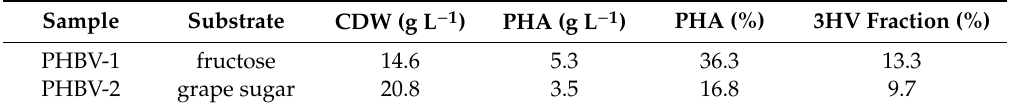
Table 2. Attributions of the main infrared peaks of the poly(3-hydroxybutyrate) (PHB) and PHBV copolymers.